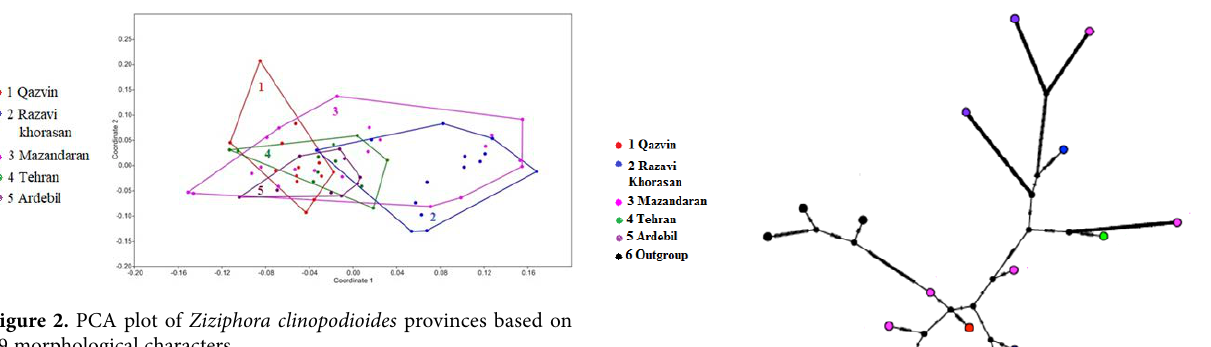
Figure 2. PCA plot of Ziziphora clinopodioides provinces based on 29 morphological characters.